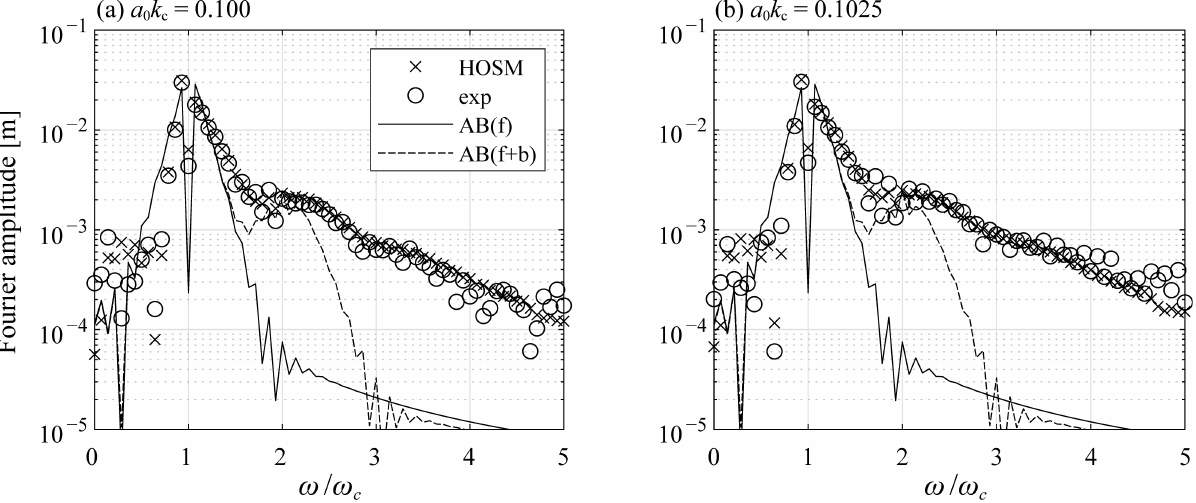
Figure 4. Comparison of the Fourier amplitudes of the modulated wave trains in the frequency domain among the experiment, HOSM simulation, and AB solution for ( a ) a 0 k c = 0.100 (non- breaking) and ( b ) a 0 k c = 0.1025 (slight